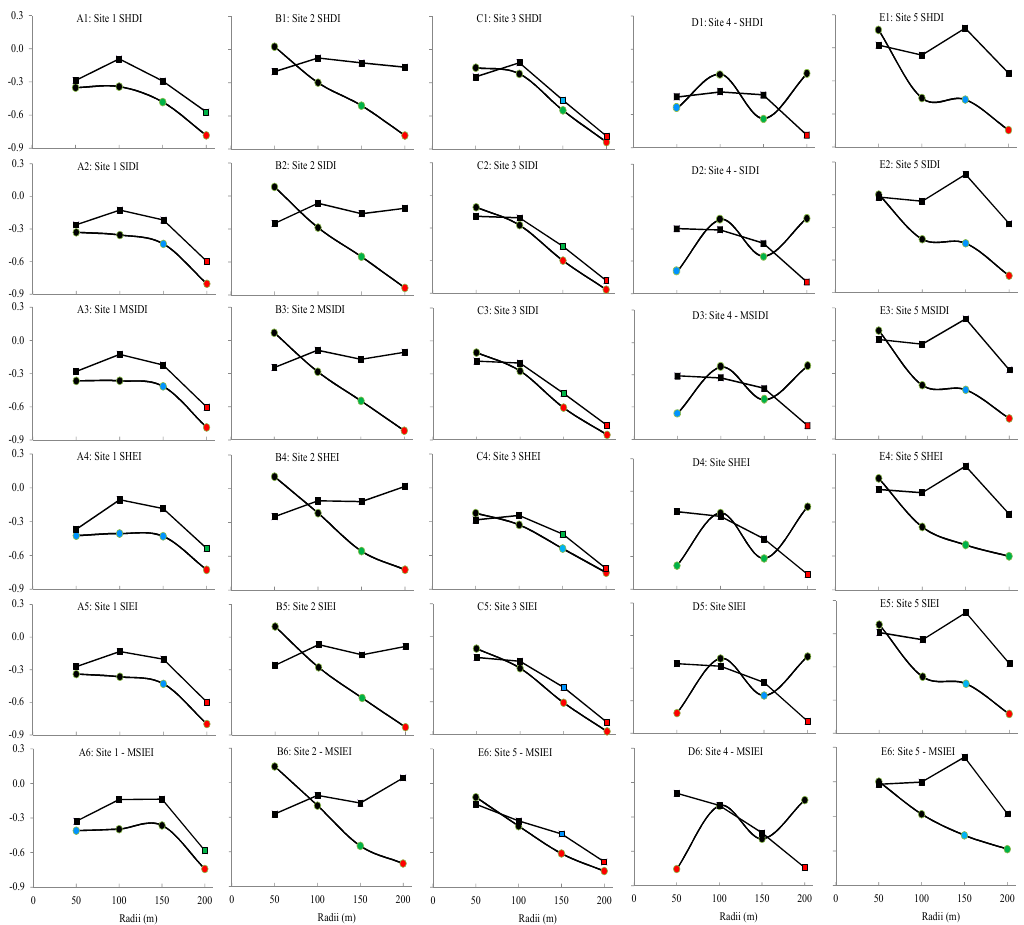
Figure 3. Scatterplots of correlation coefficients (R in the vertical axis) between the abundance of Laodelphax striatellus and the diversity indices of agricultural landscapes at four radii patterns (in the horizontal axis). The circle and square represent the nymphal and adult insect stages, respectively. The red, green, and blue colors display the significance of the Pearson’s test at the 0.01, 0.05, and 0.10 levels, respectively. The column represents five study sites from left to right: TongXiang, XinFeng, PingHu, XinHuang, and HaiYan, and the row shows the six diversity metrics from top to bottom: SHDI, SIDI, MSIDI, SHEI, SIEI, and MSIEI.